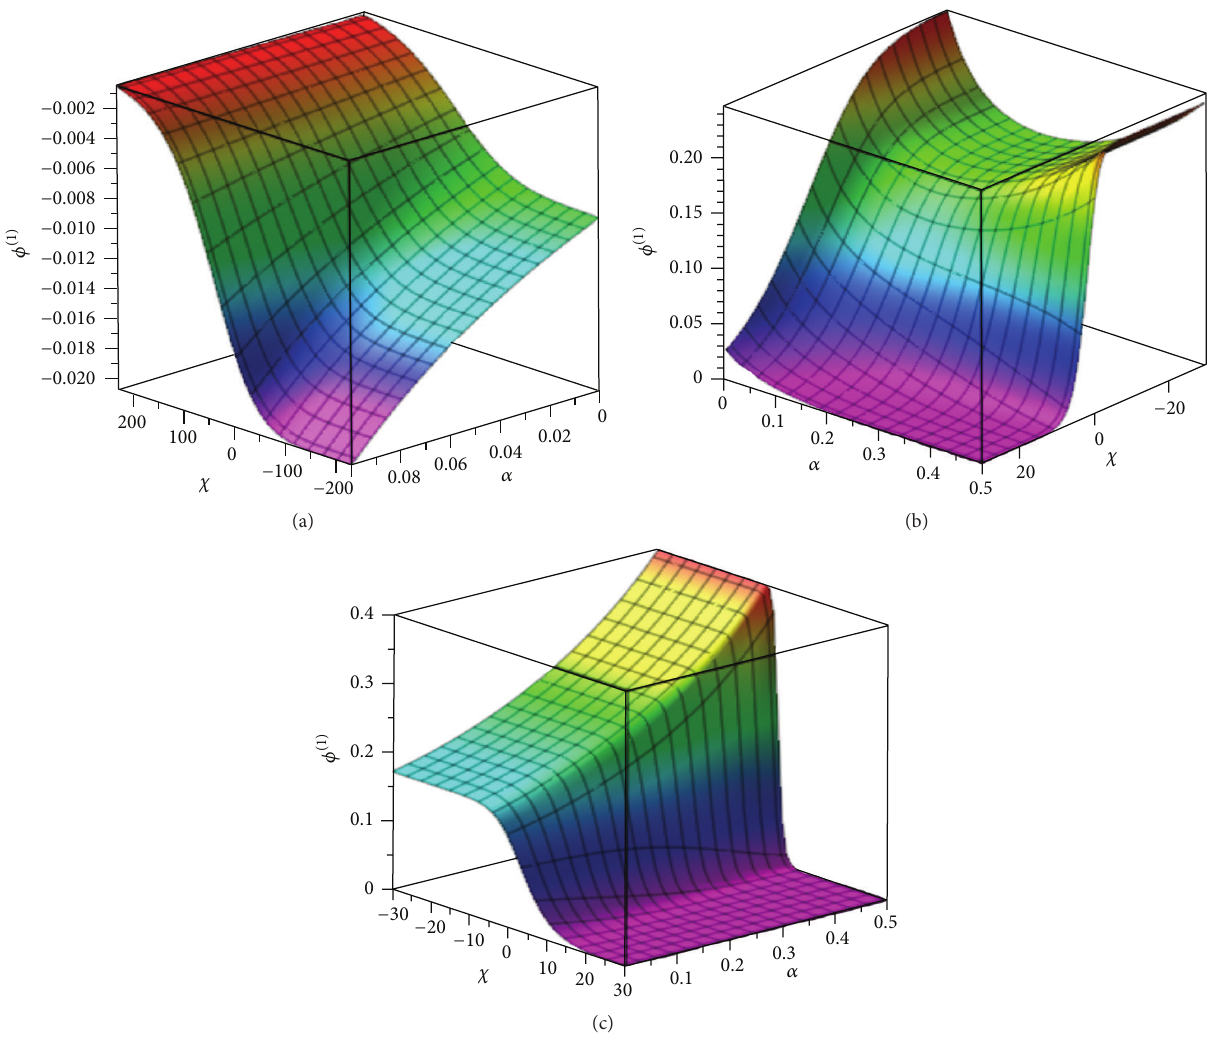
Figure 4: Variation of electrostatic shock waves with respect to 𝜒 and 𝛼 for (a) 𝑞 = −0.6 (superthermality), (b) 𝑞 = 0.4 (superthermality), and (c) 𝑞 = 1.6 (subthermality) taking the fixed values of 𝛼 = 0.1 , 𝛽 = 0.1 , 𝛿 = 0.01 , and 𝜇 0 = 0.8 .